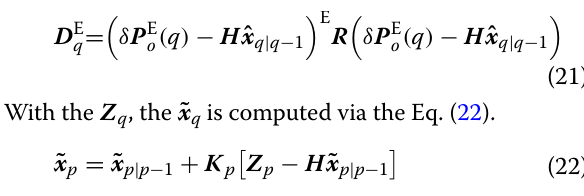
The FIR filter assisted with the predictive model/ELM integrated for model (1)(4) is listed in Algorithm 2.